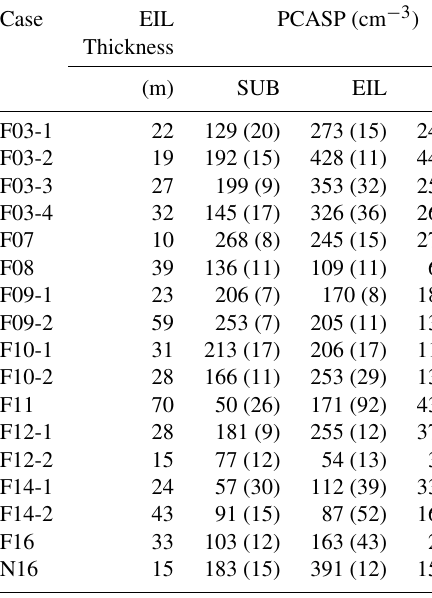
Figure 2. F07 on 1 August 2016 showing how thermodynamic and dynamic criteria were applied to define the vertical bounds of the EIL, which separates the STBL from the FT. This subset of data is obtained from an upward spiral sounding. Table 1. Summary of EIL thickness and particle concentrations (average (relative standard deviation as a percentage)) for the sub-cloud layer (SUB), the entrainment interface layer (EIL), and the free troposphere (FT). The cases are labeled with the campaign (F = FASE, N = NiCE), research flight number, and case number (only for flights with more than one spiral) from that flight (i.e., “F12-2” is the second spiral sounding case from FASE research flight